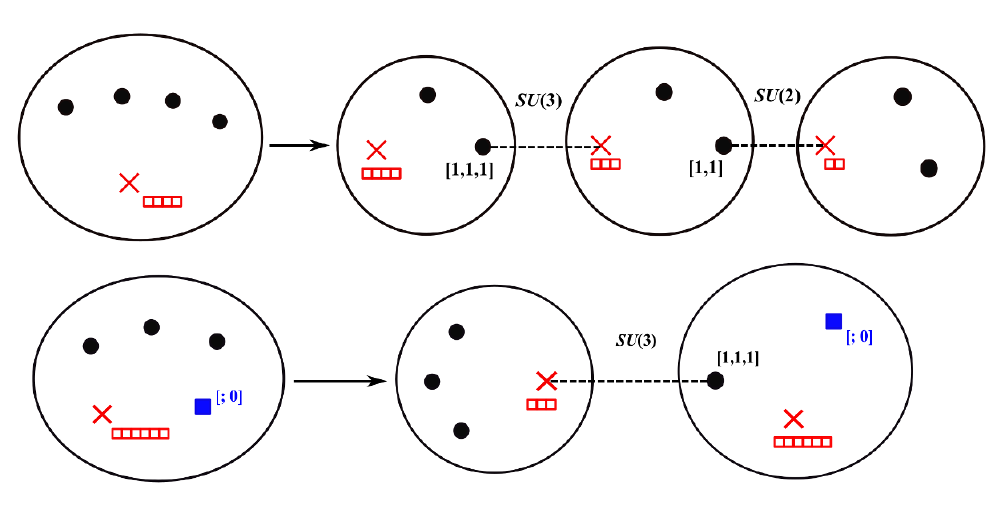
Figure 6 . Another S-duality frame. The upper one is from A 3 perspective. Here in the weakly coupled description, the rightmost theory is still ( A 1 ; D 2 k +2 ), the middle theory is given by (cid:2) ( k +1) ; [1 ; 1 ; 1] (cid:0) (cid:1) III [2 ; 1] ; F , and the leftmost theory is given by k; 1 one is from the D 3 perspective. The left theory without blue marked points should be understood as A 2 theory. The right hand theory is given by be done similarly by replacing full puncture F to be other arbitrary regular puncture Q